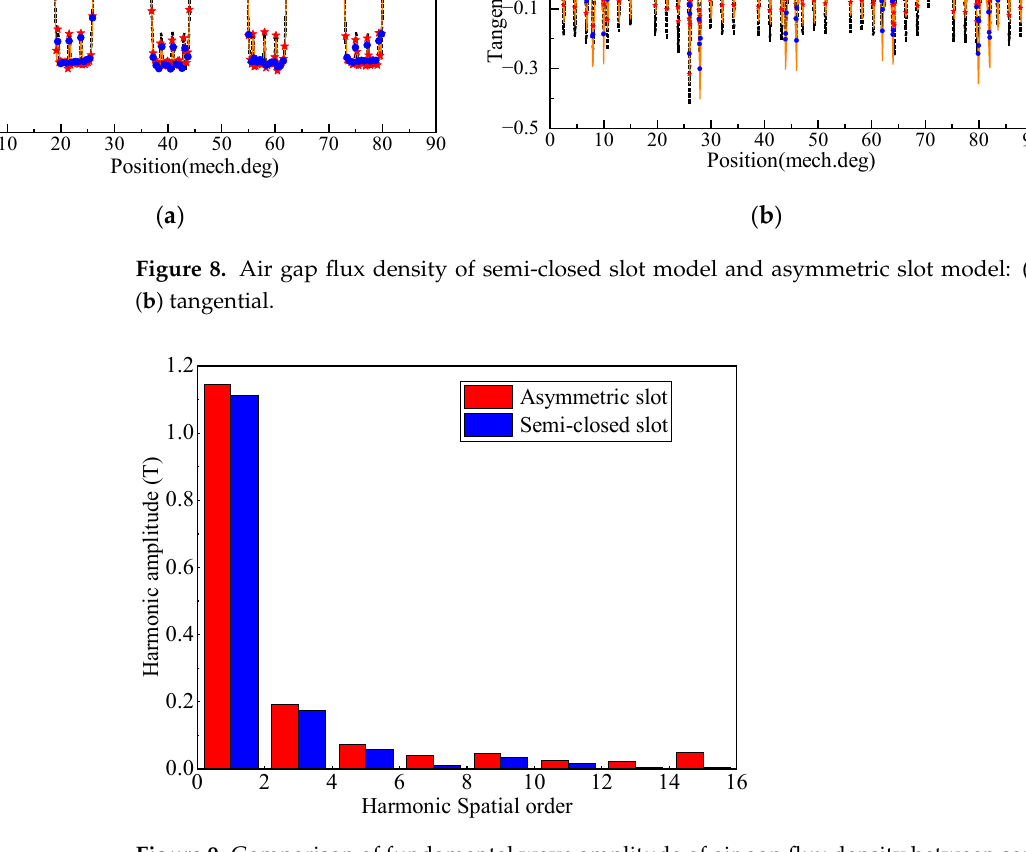
Figure 9. Comparison of fundamental wave amplitude of air gap flux density between semi-closed slot model and asymmetric slot model.